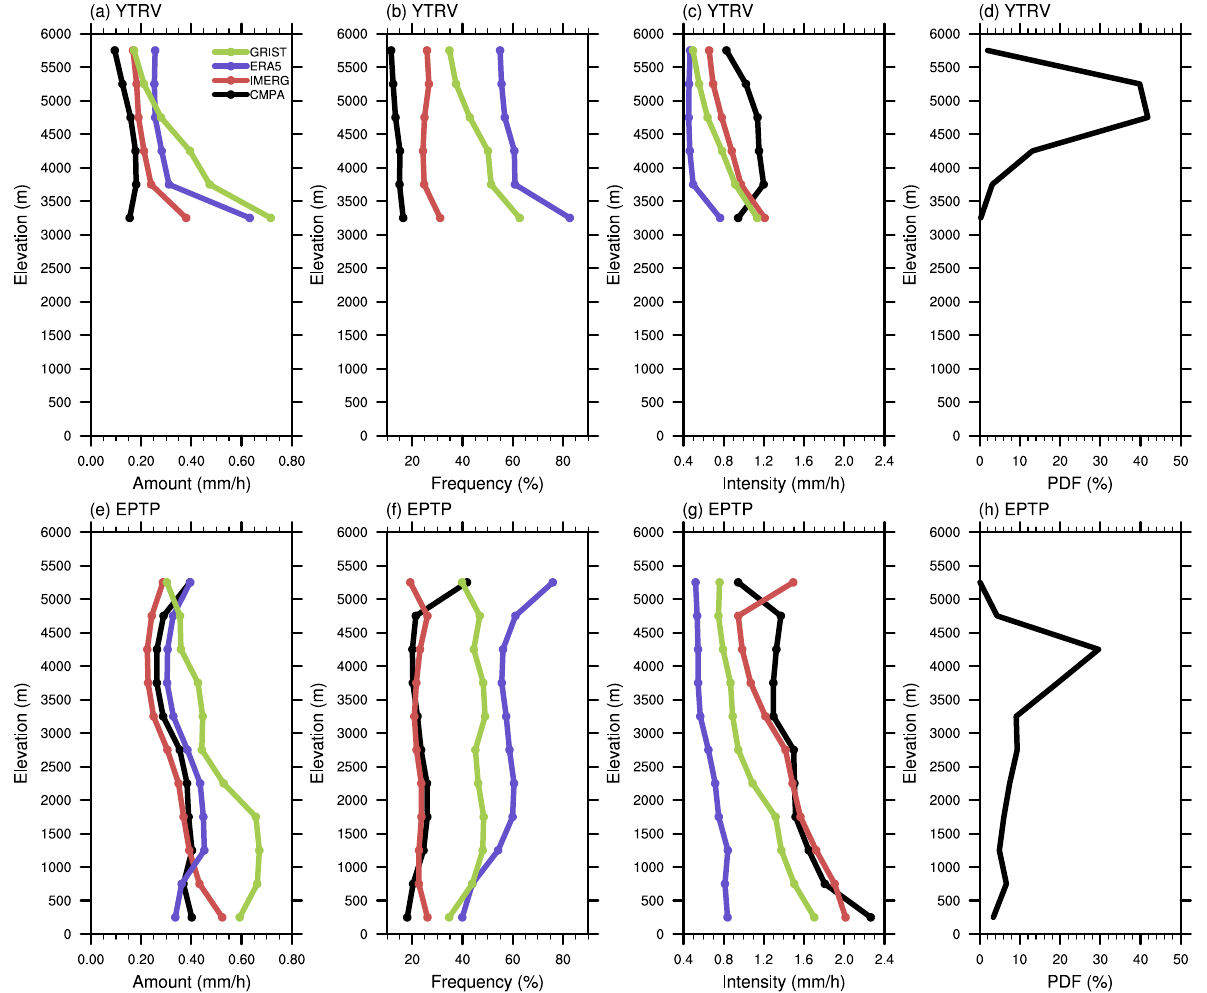
Figure 7. Elevation dependence of mean precipitation variables (first column: amount (mm/h); second column: frequency (%); third column: intensity (mm/h)) in selected sub-regions, YTRV ( a – c ) and EPTP ( e – g ). The black line and dots stand for the CMPA dataset, red for IMERG, violet for ERA5, and green for GRIST. The right-most column shows the probability density function (PDF) of elevation (( d ): YTRV and ( h ):